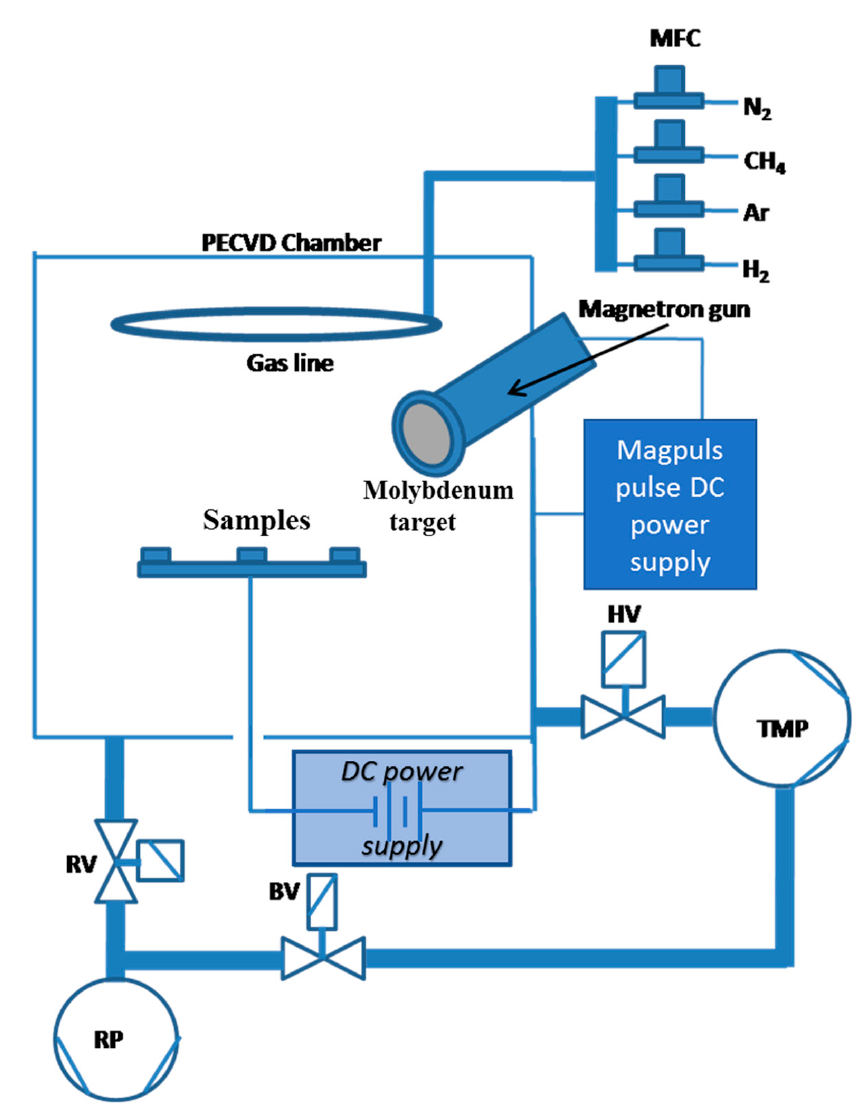
Figure 1. Schematic image of PECVD system used for the deposition of Mo-DLC coatings where TMP—Turbomolecular pump, RP—Roughing pump, RV—Roughing valve, BV—Backing valve, HV—High vacuum valve, and MFC—Mass flow controller.